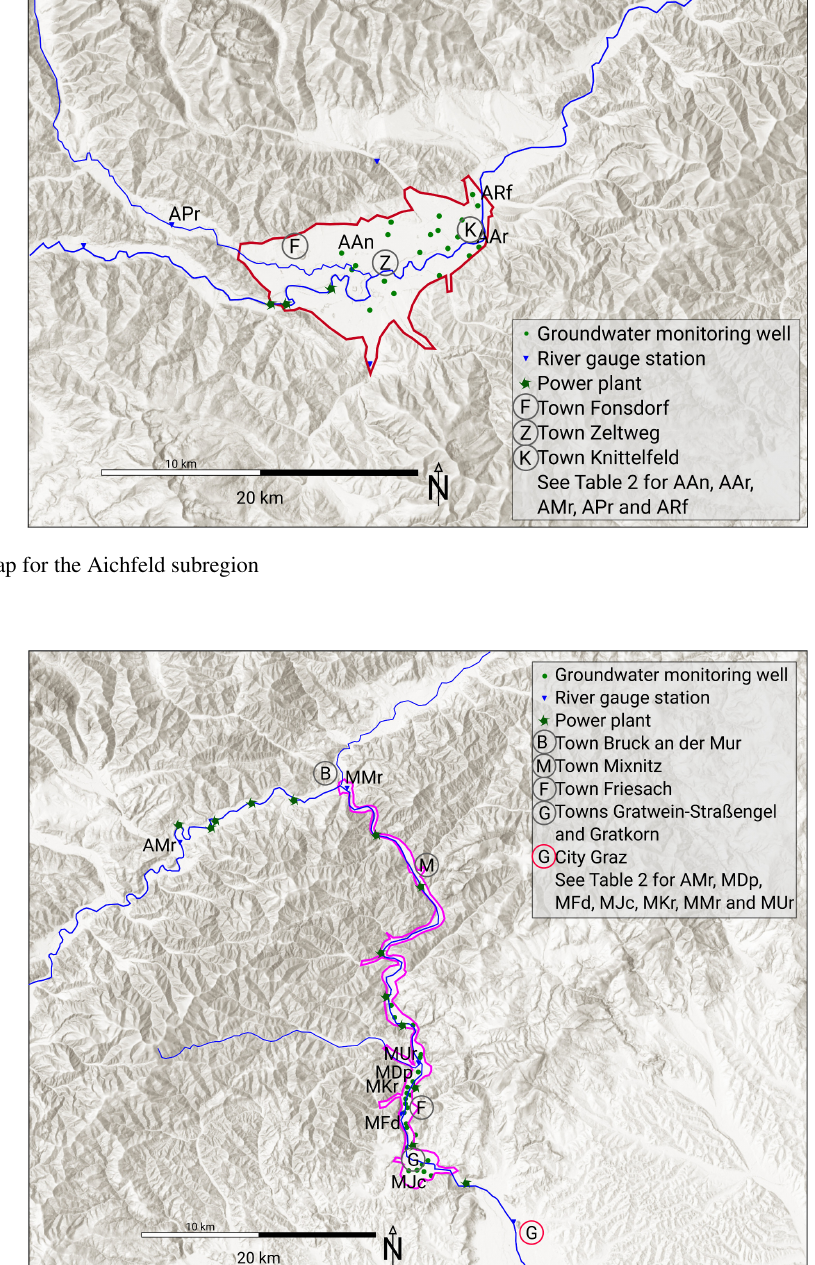
Hydrol. Earth Syst. Sci., 21, 2421–2448,